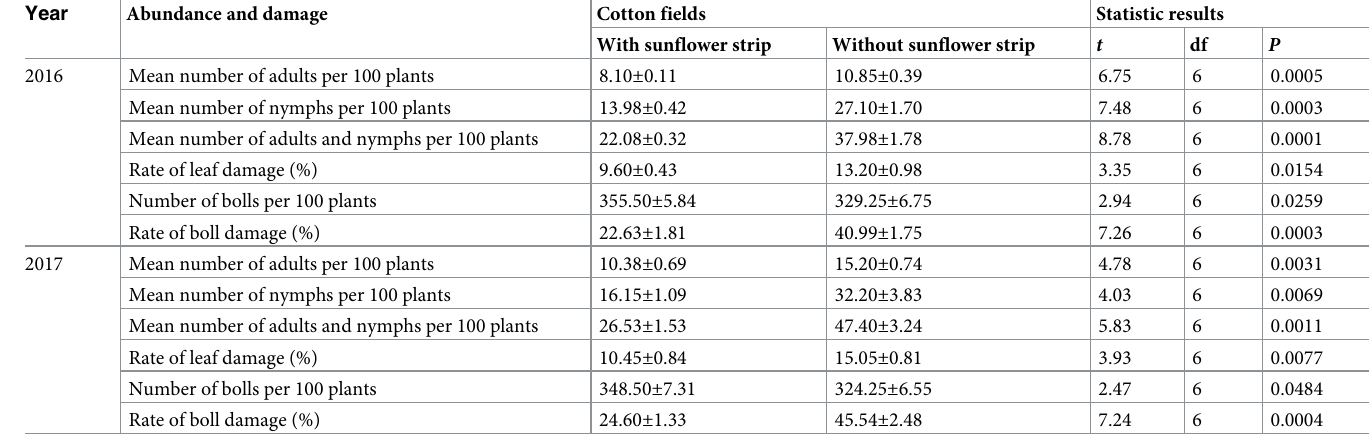
Table 2. Abundance and damage of Lygus pratensis to cotton plants in fields with and without sunflower strips, during 2016 and